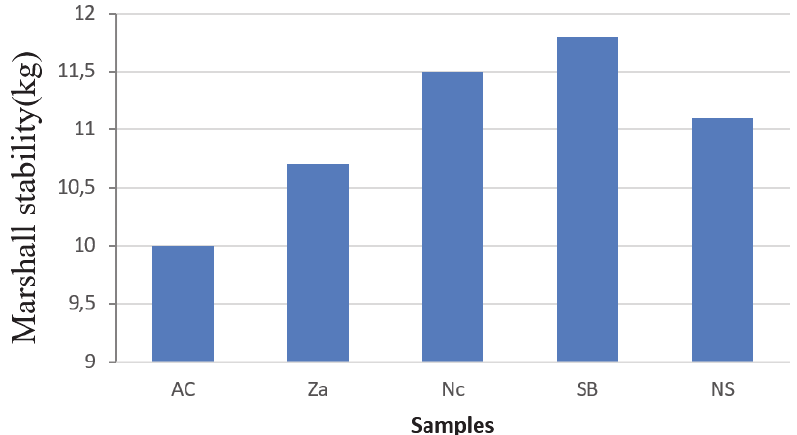
Figure 2: Results of Marshall stability for modified and non-modified